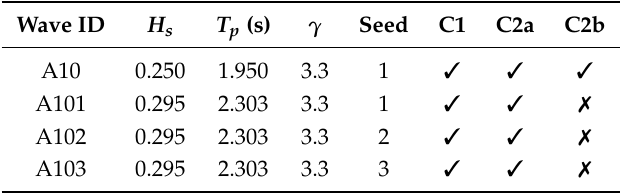
Table 8. Extreme wave tests